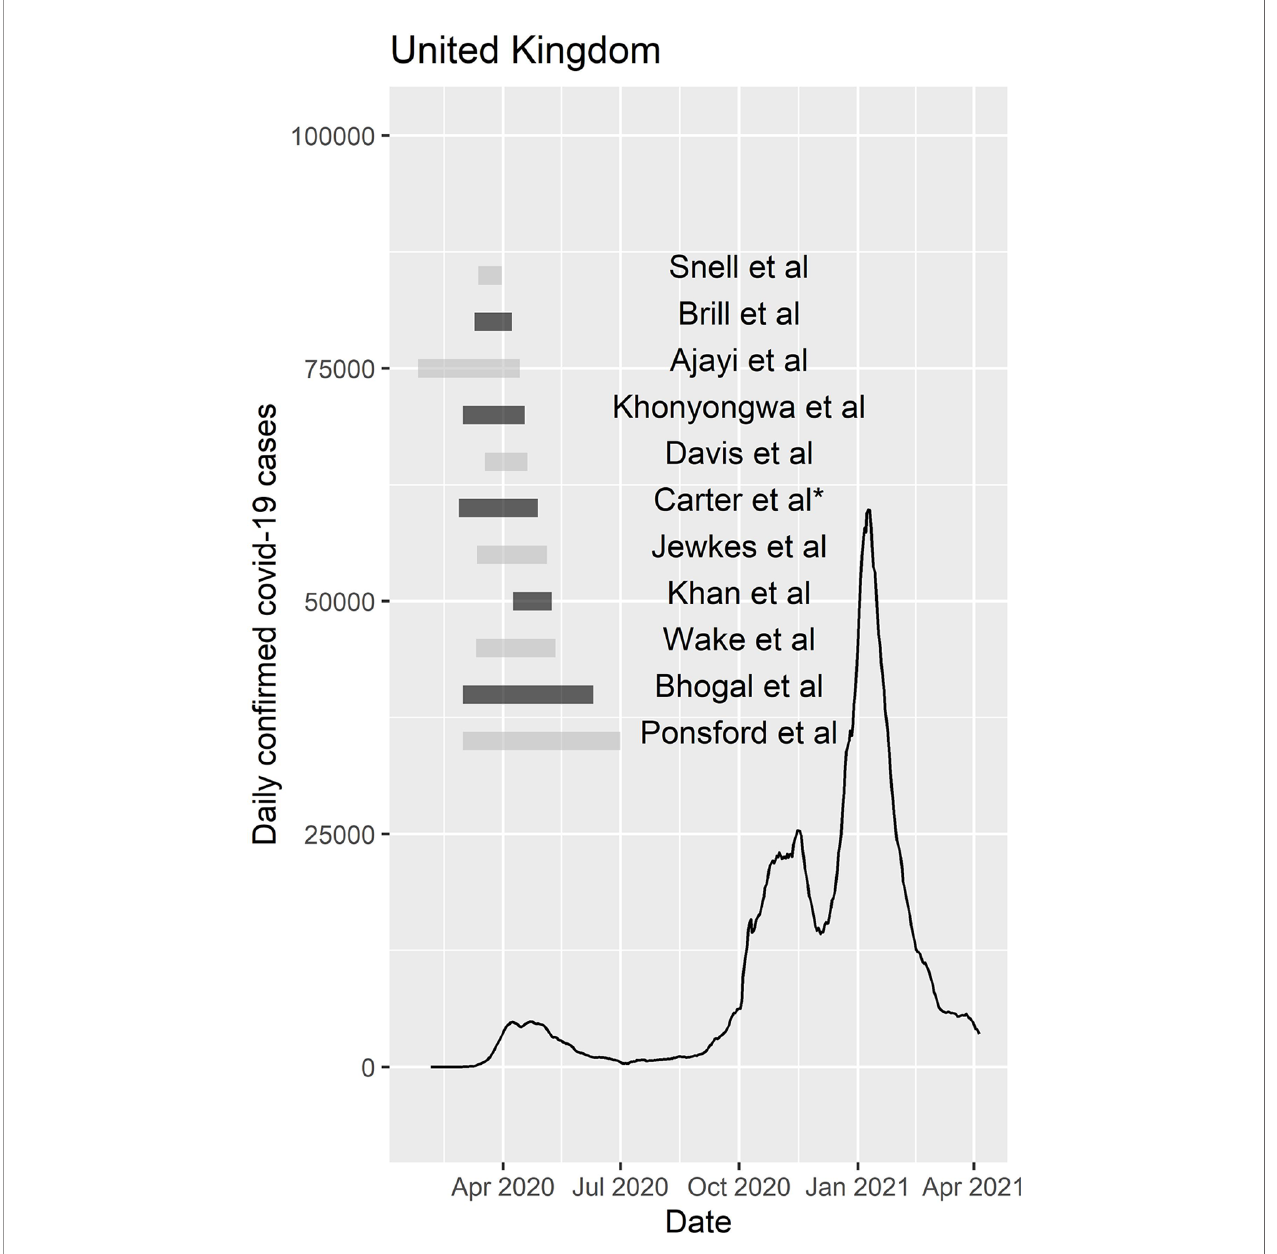
FIGURE 2 | Timing of UK studies relative to national COVID-19 rates. Plot showing the timing of individual studies included within the primary meta-analysis reporting patients within the United Kingdom (UK), relative to national daily COVID-19 case diagnosis rates January 2020 and April 2021. * The study by Carter et al. is included here as 10/11 hospital sites were within the